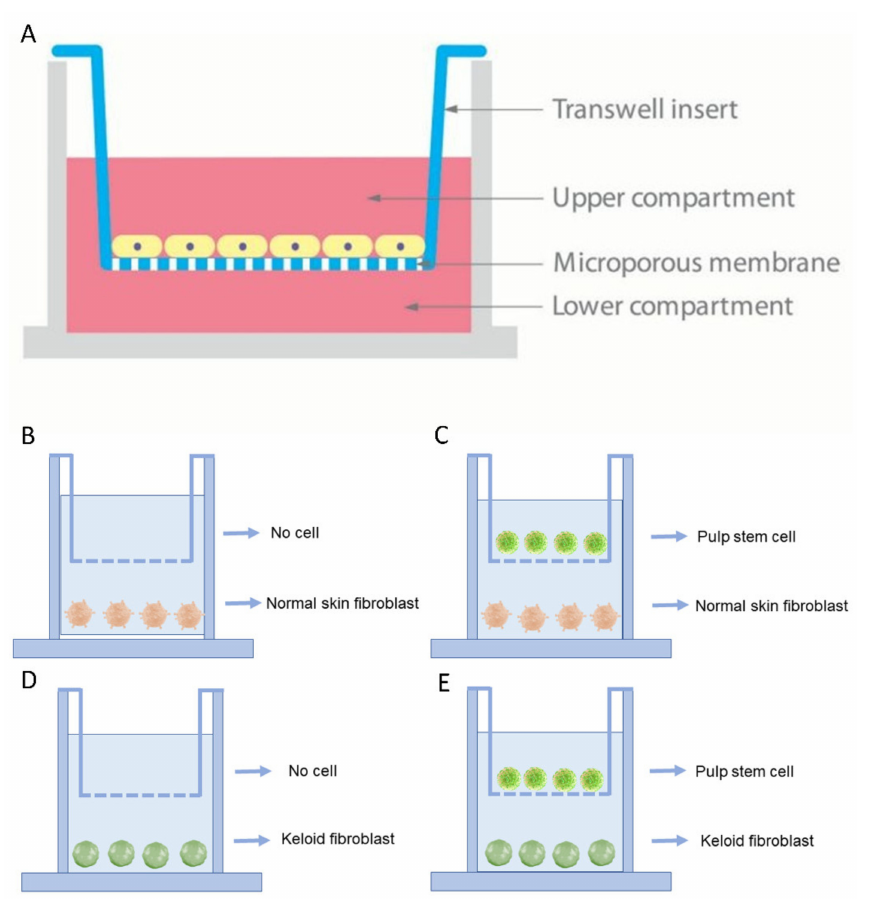
Figure 1. Study design. ( A ): A schematic design of the Transwell co-culture model was established using Transwell chambers with a 0.4-micrometer pore size that allows for the passage of chemical and biochemical molecules. ( B – E ): 4 combinations of the inducing and differentiating